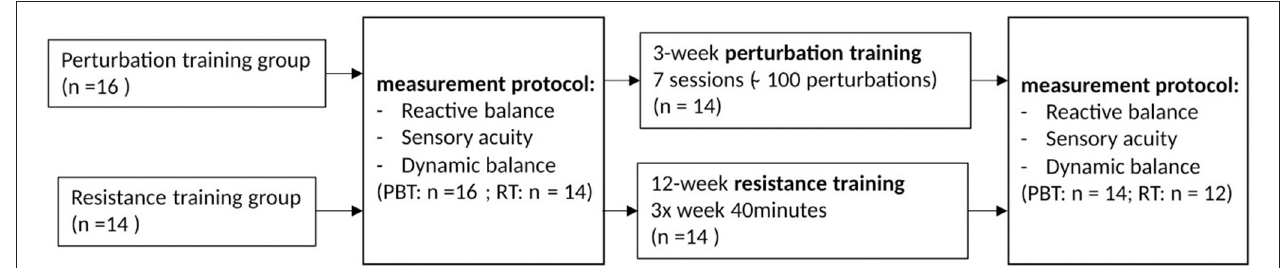
FIGURE 1 | Flow chart of intervention study with pre- and post-intervention